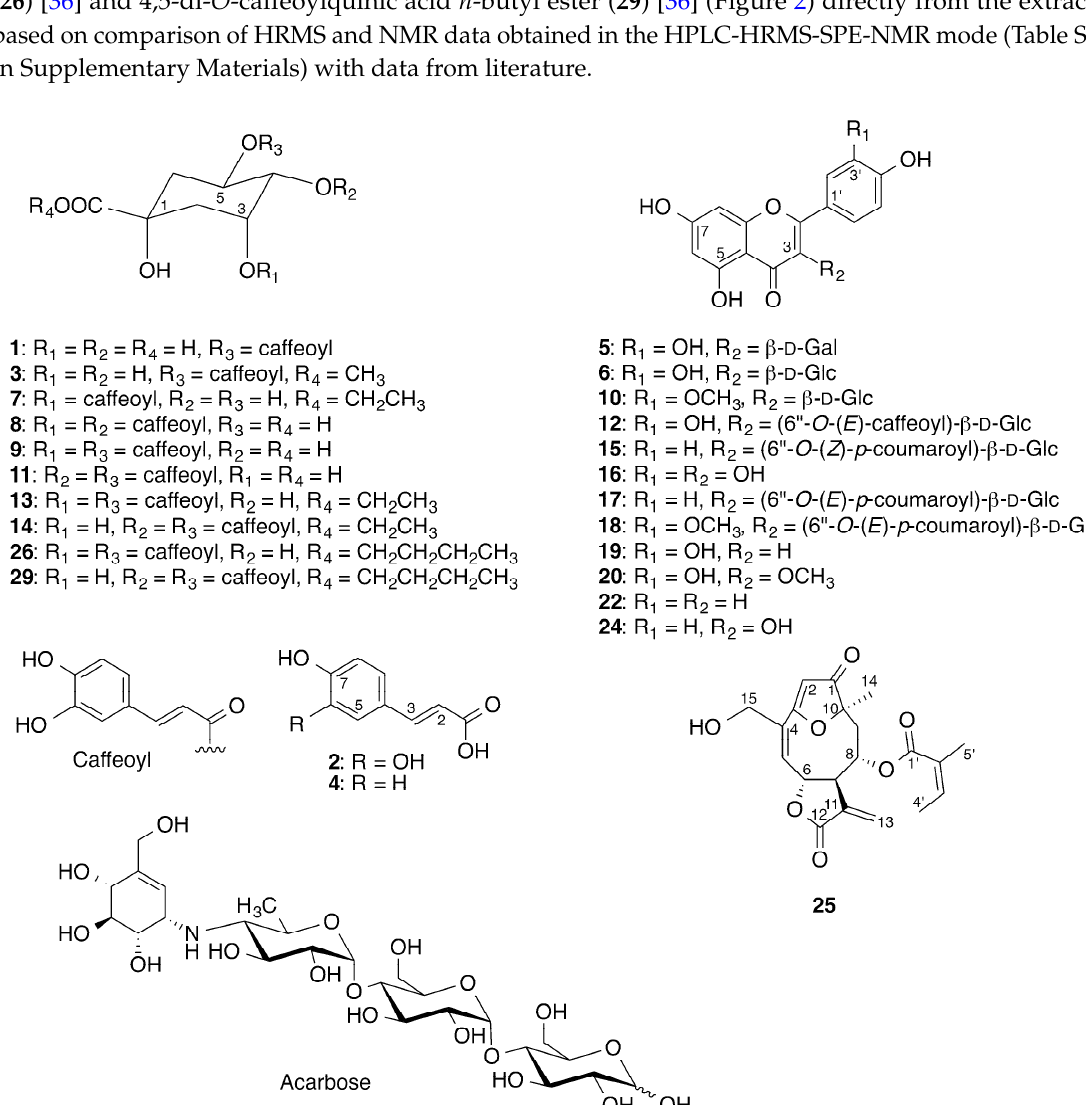
Figure 2. Acarbose and compounds identified in Eremanthus crotonoides .